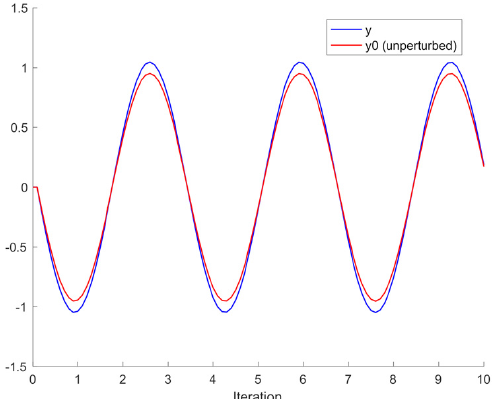
Figure 16. Output of the perturbed ( E , A ) and unperturbed ( E 0 , A 0 ) systems in Example